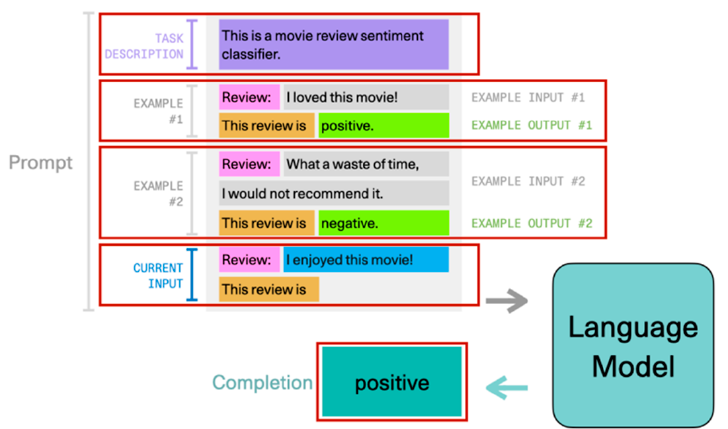
Figure 5. Examples of a prompt generation sequence for a Large Language Model. Adapted from Prompt Generation documentation by Cohere [338].